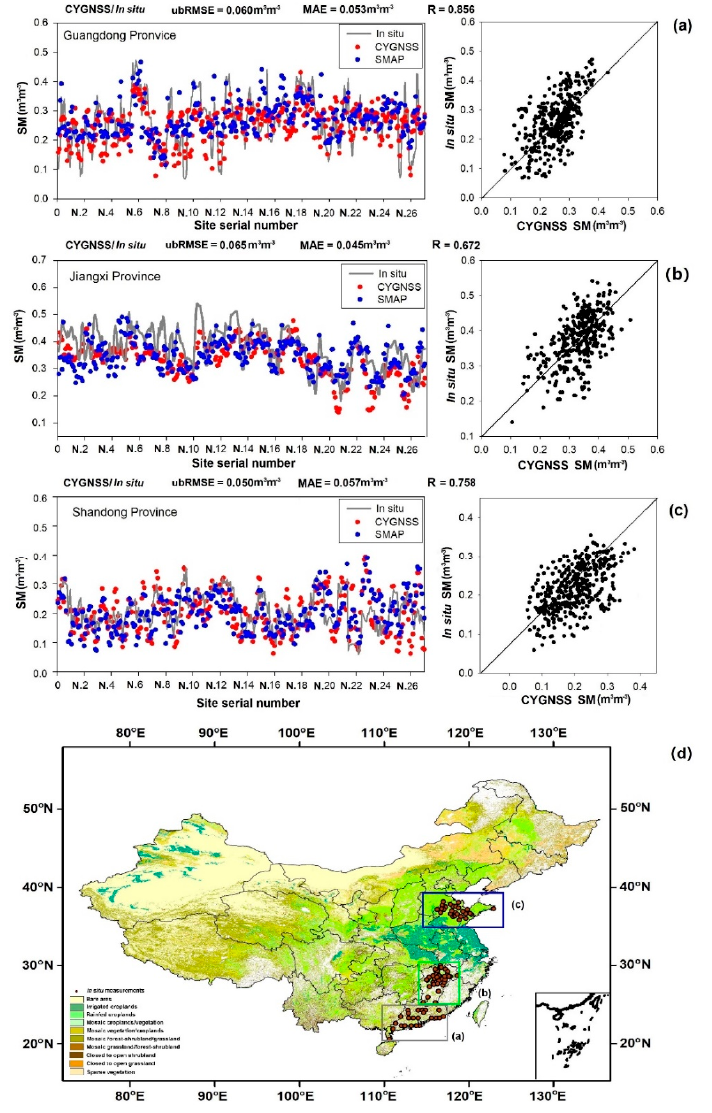
Figure 12. Correlations of the SM derived from CYGNSS, SMAP SM, and in situ measurements for three provinces with typical climate conditions, ( a ) Guangdong Province, ( b ) Jiangxi Province, ( c ) Shandong Province, ( d ) the sites distribution.